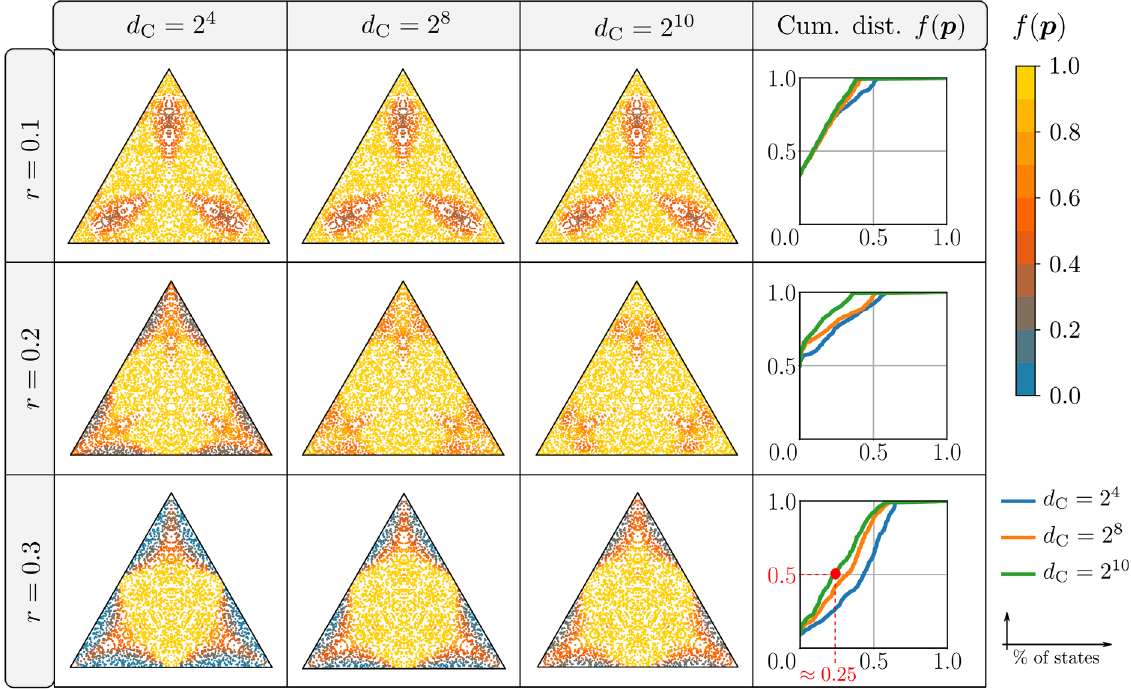
FIG. 6. Fraction f ð p Þ of all states inside the catalytic activation set of p that can be catalyzed using a multicopy catalyst composed of n ∈ f 4 ; 8 ; 10 g qubits ω diag ð 1 − r; r Þ , for different values of parameter r . Column 4 shows a cumulative distribution of f ð p Þ ; i.e., it C ¼ illustrates the fraction of catalytic transformations that can be activated using a multicopy catalyst. For example, the red exemplary point indicates that for around 0.25 of all possible input states p , a quantum system composed of n ¼ 10 qubits in a state with r ¼ 0 . 3 acts as a catalyst for less than 0.5 of all possible output states q in CAS. Equivalently, for this choice of parameters, the multicopy catalyst can activate more than 0.5 of all possible transformations for approximately 0.75 of all possible input